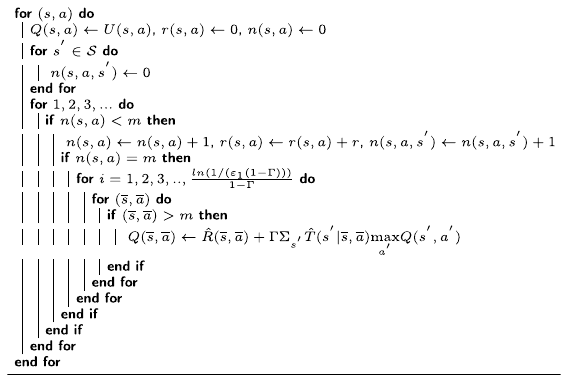
Algorithm 2 PAC‑RL